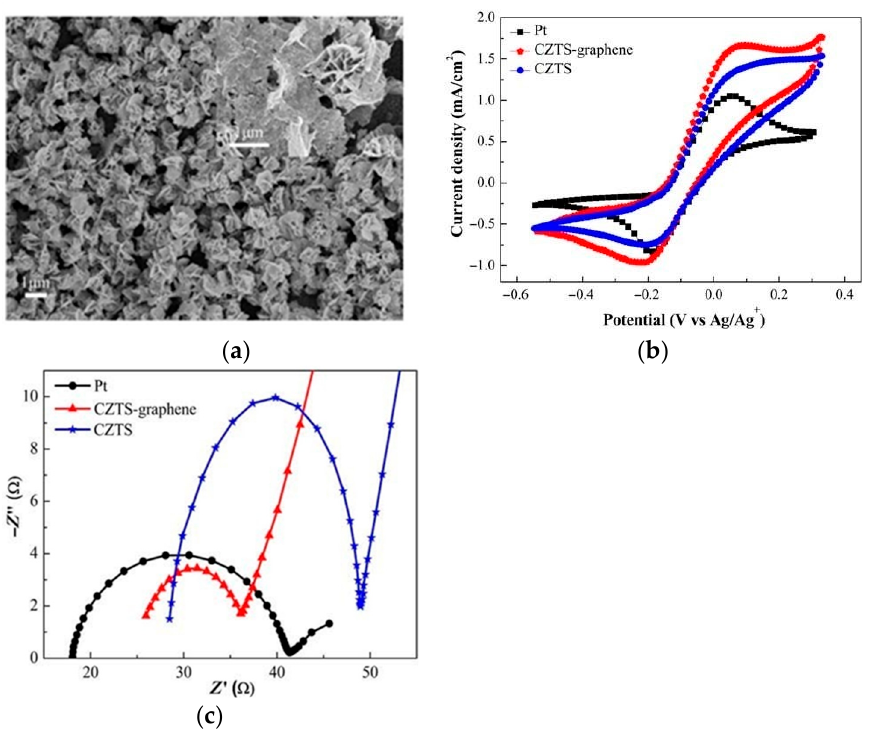
Figure 12. ( a ) SEM, ( b ) CV, and ( c ) EIS micrographs for Pt, Copper-zinc-tin-sulphide (CZTS), and CZTS–graphene. Reproduced with permission from Reference [54], Elsevier 2016.